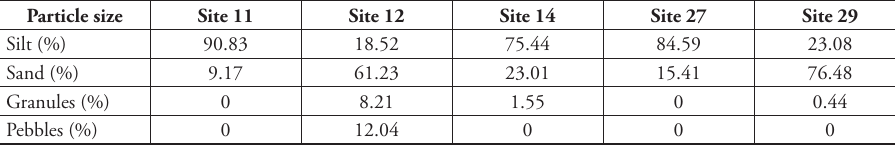
Table 2. Characteristics of sediment particle size of S. carinata Particle